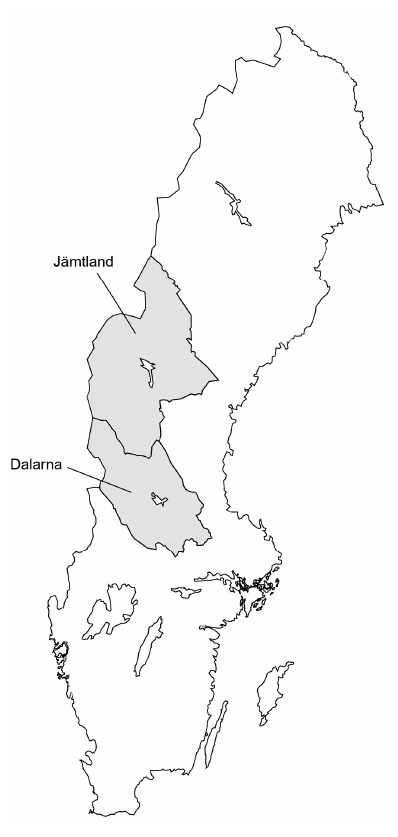
Figure 1. The location of the studied Swedish counties Dalarna and Jämtland.